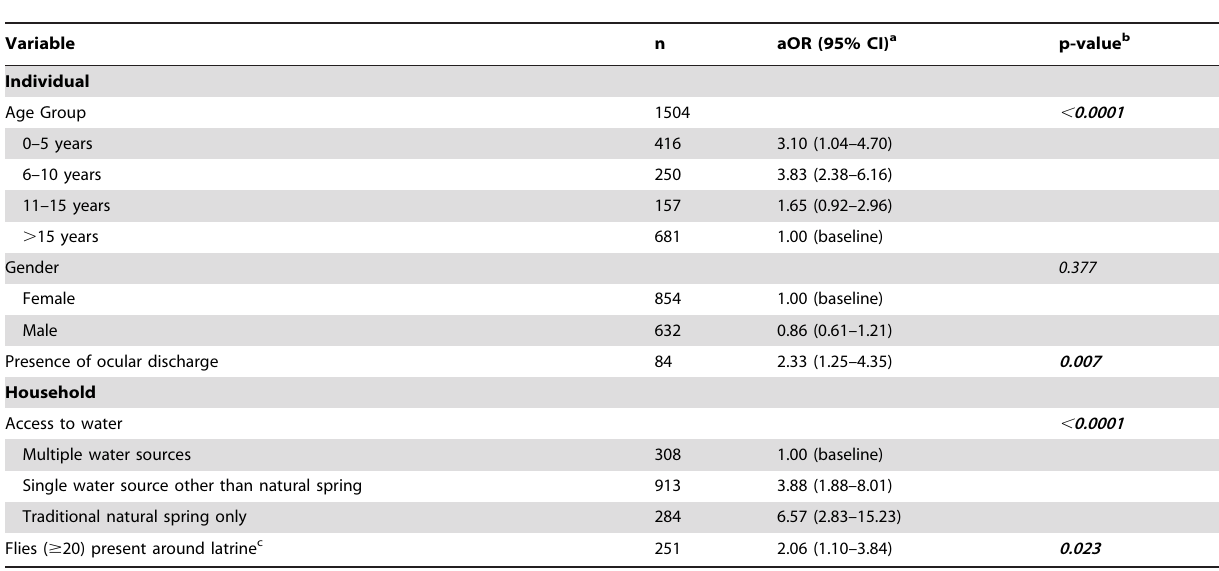
Table 6. Multilevel multivariable random effects logistic regression analysis of factors associated with ocular C. trachomatis